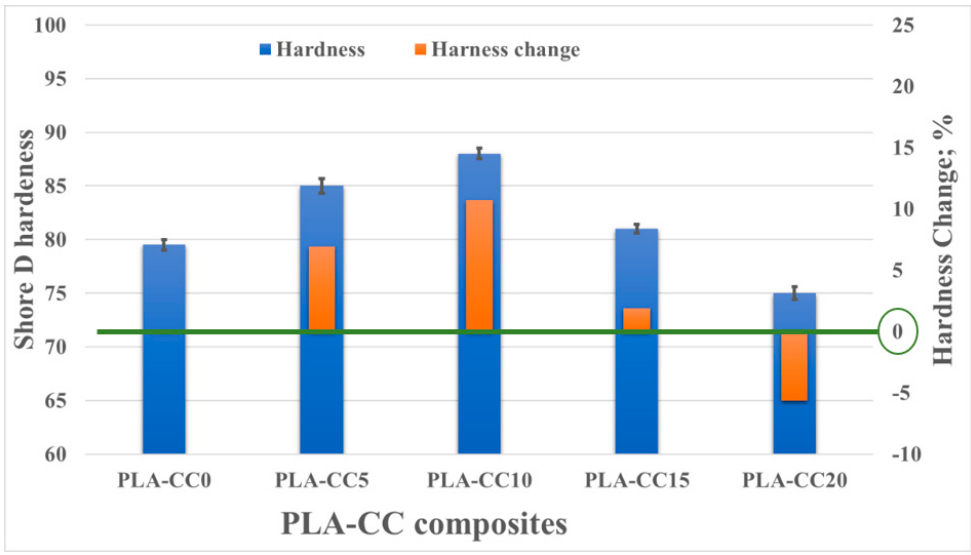
Figure 8. PLA-CC composites hardness for different corn cob weight